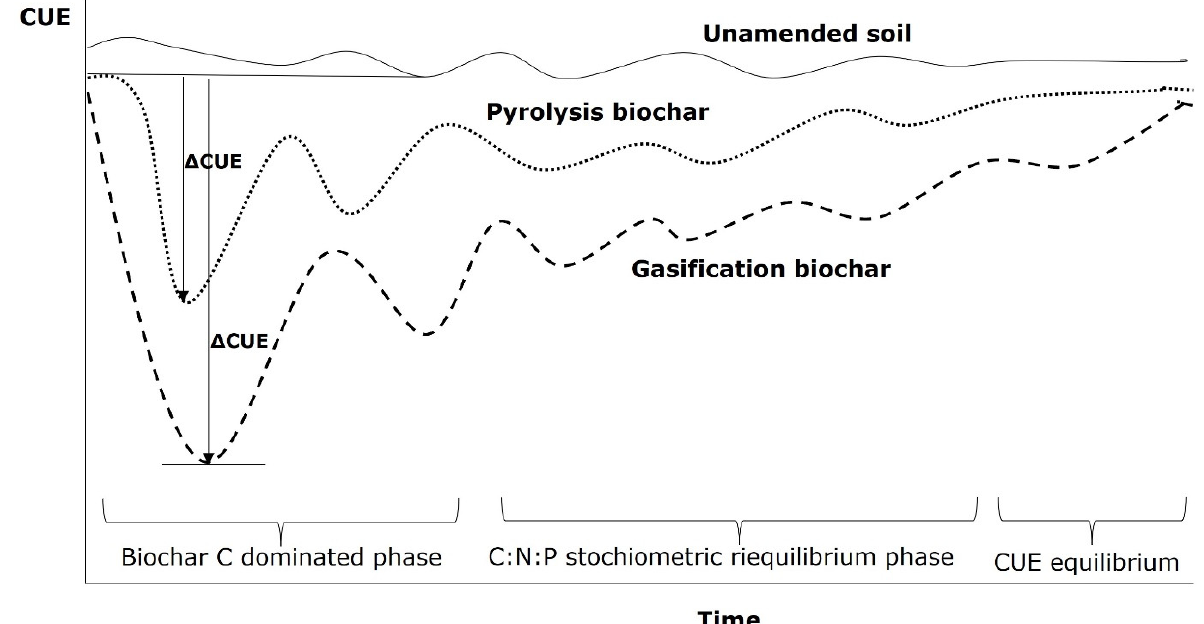
Figure 2. CUE in unamended soil, in soil amended with biochar produced by pyrolysis (pyrolysis biochar) and in soil amended with biochar produced by gasification (gasification